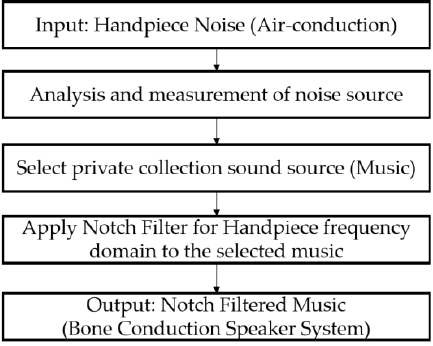
7 of 12 Table 2. The sound sources for clinical trial. Sound sources A: (Base) Handpiece noise B: Handpiece noise + Music C: Handpiece noise + Notch-filtered music Subjective noise intensity